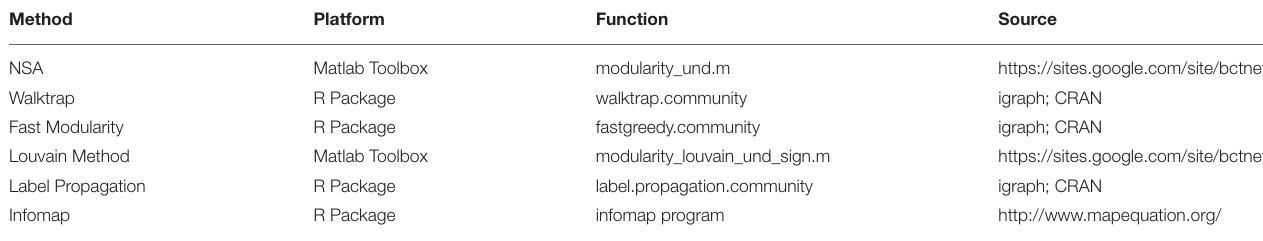
TABLE 1 | Community detection methods